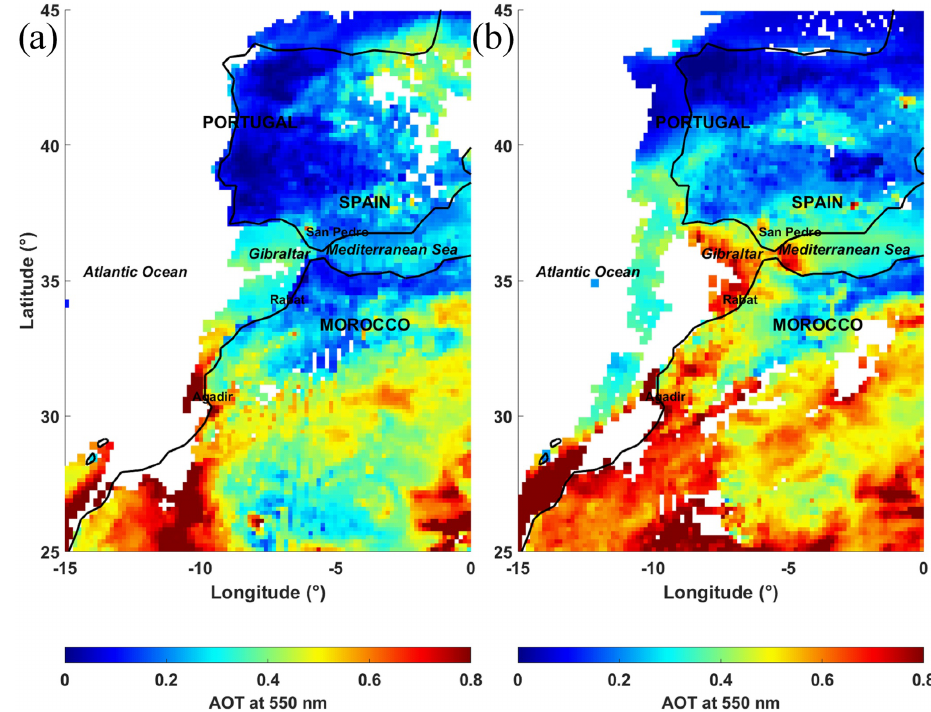
Figure 11. Aerosol optical thickness (AOT) at 550nm derived from MODIS on (a) 13 August 2011 and (b) 11 August 2011.